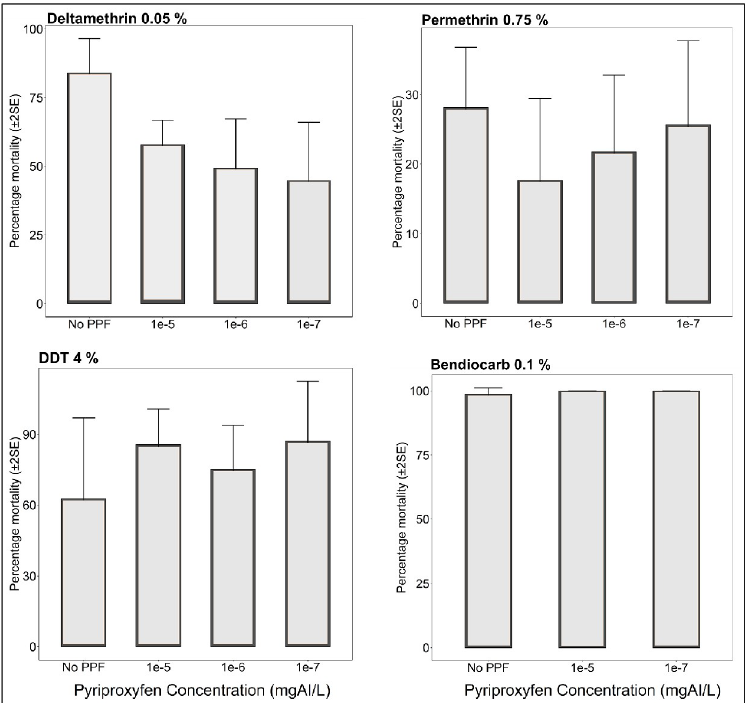
Fig 4. Percentage mortality of wild resistant An . arabiensis mosquitoes collected as 3 rd instar larvae reared through different doses of PPF (mg of active ingredient per litre, i.e. mgAI/L) and exposed to commonly used insecticides using standard WHO susceptibility testing guidelines. “No PPF” control represents % mortality of wild mosquitoes from the same village, which was not treated with PPF but was exposed to the same insecticide at standard WHO-recommended